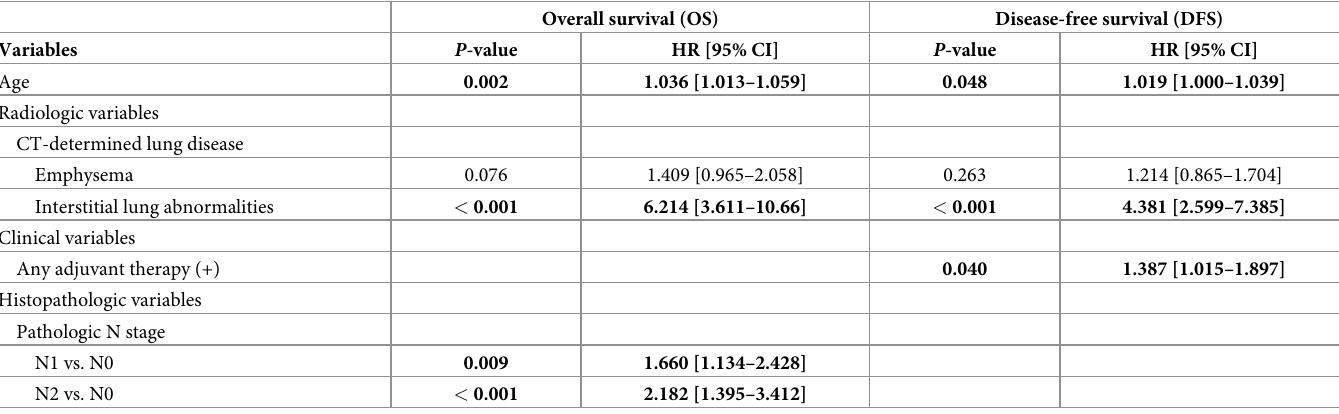
Table 3. Multivariate Cox regression analysis between variables and overall survival and disease-free survival.